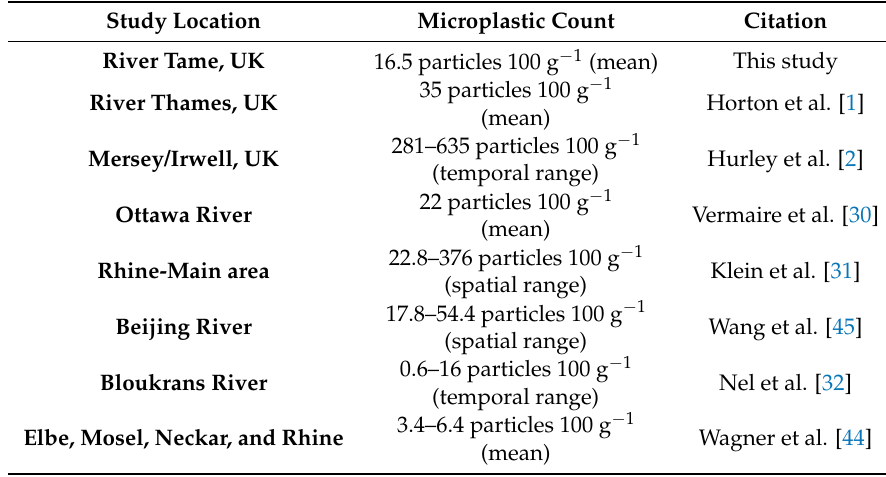
Table 3. Examples of recently published data on microplastic abundance in freshwater